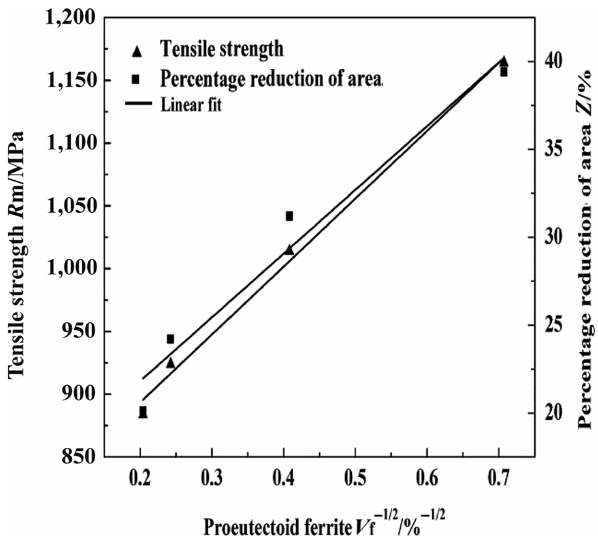
Figure 6: Effect of proeutectoid ferrite on tensile strength and per- centage of area